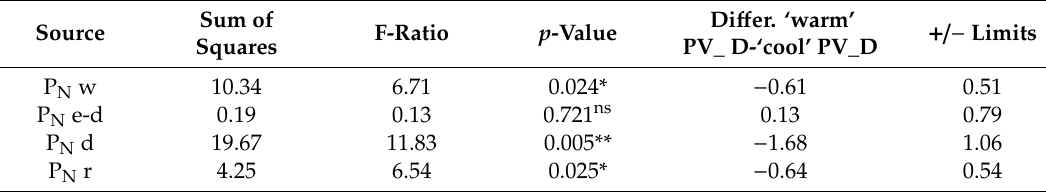
Table 2. Discrimination of the means using RM ANOVA between the drought variants of two provenances (‘warm’ PV_D and ‘cool’ PV_D) for photosynthetic rate (P N ), stomatal conductance (g S ), abscisic acid (ABA) content, proline (Proline) content, osmotic potential ( Ψ S ), predawn water potential ( Ψ pd ), and relative water content (RWC) on four di ff erent timescales (w: whole experiment period, e-d: early drought, d: drought, r: recovery); statistically significant di ff erences are noted with an asterisk as follows: p > 0.05 ns, * p ≤ 0.05, ** p ≤ 0.01, and *** p ≤ 0.001. +/ − Limits is a threshold value; if